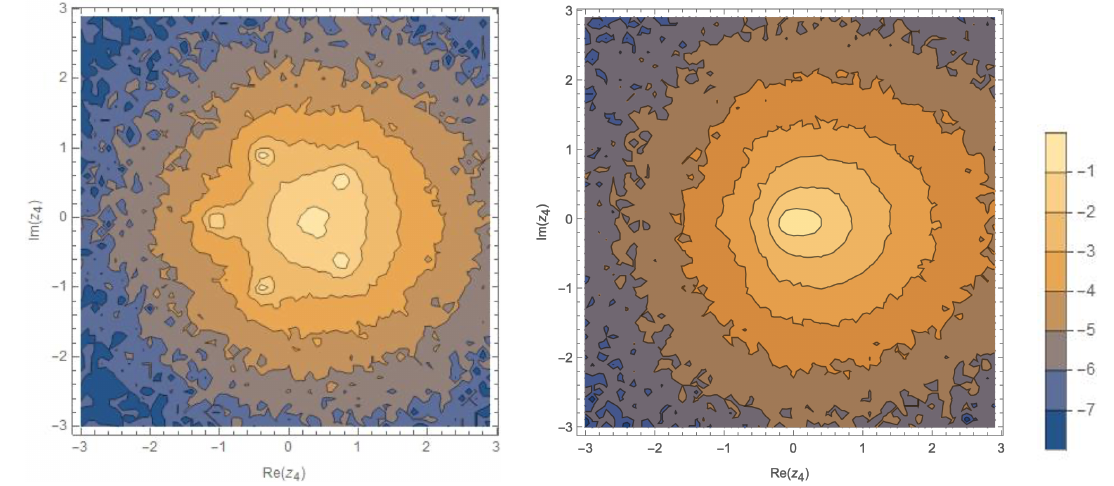
Figure 7 . Distribution of log density points for the Fermat quintic (left) and Dwork quintic ( ψ = − 1 , right), the points are projected to one complex plane along the coordinate z 5